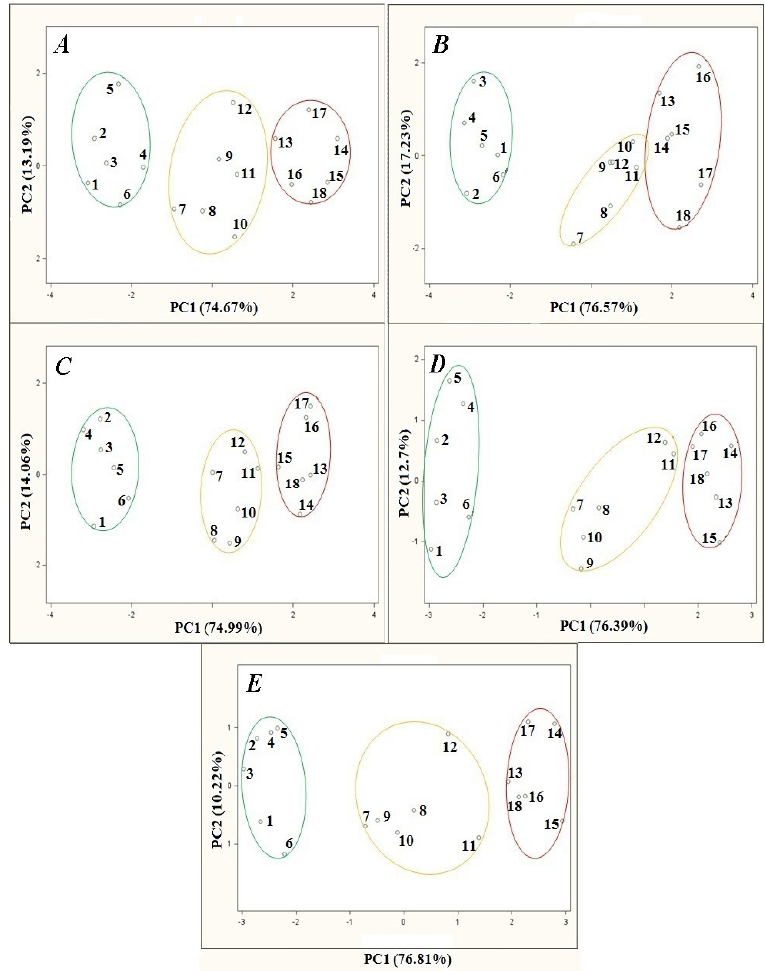
Figure 3. PCA results for samples of agricultural distillates obtained for different barbotage temperatures: ( A ) 35 °C; ( B ) 30 °C; ( C ) 25 °C; ( D ) 20 °C; ( E ) 15 °C; points: 1–6—high quality class distillates (green), 7–12—medium quality class distillates (yellow), 13–18—low quality class distillates